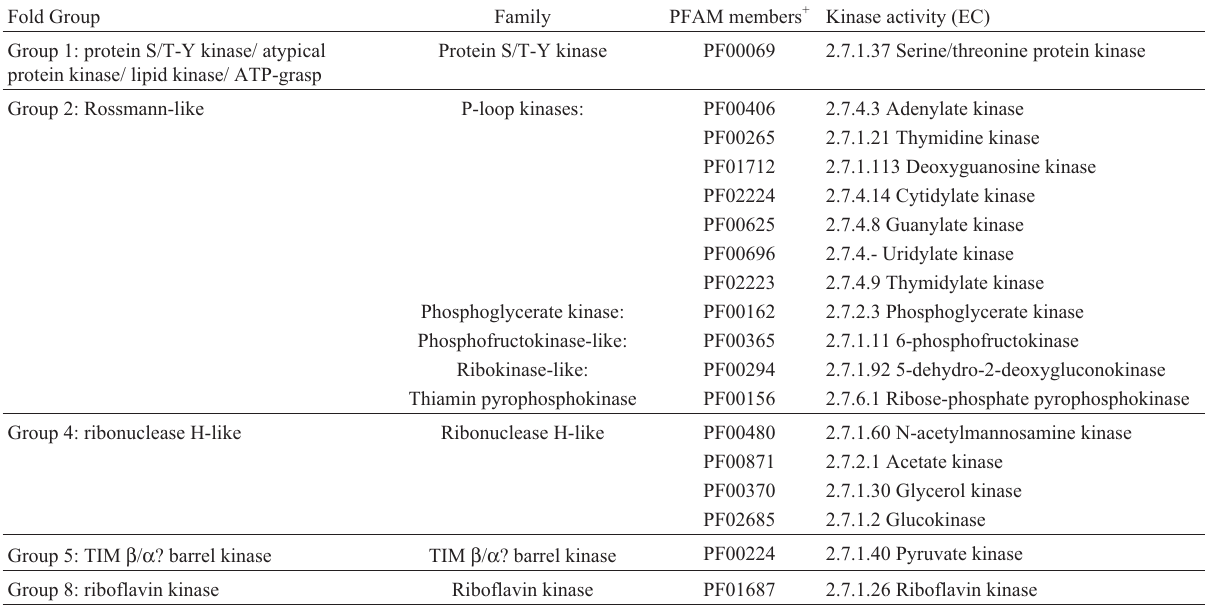
Table 2 - Classification of M. synoviae and M. hyopneumoniae kinase activities by family and fold group*. Fold Group Family PFAM members + Kinase activity (EC) Group 1: protein S/T-Y kinase/ atypical Protein S/T-Y kinase protein kinase/ lipid kinase/ ATP-grasp